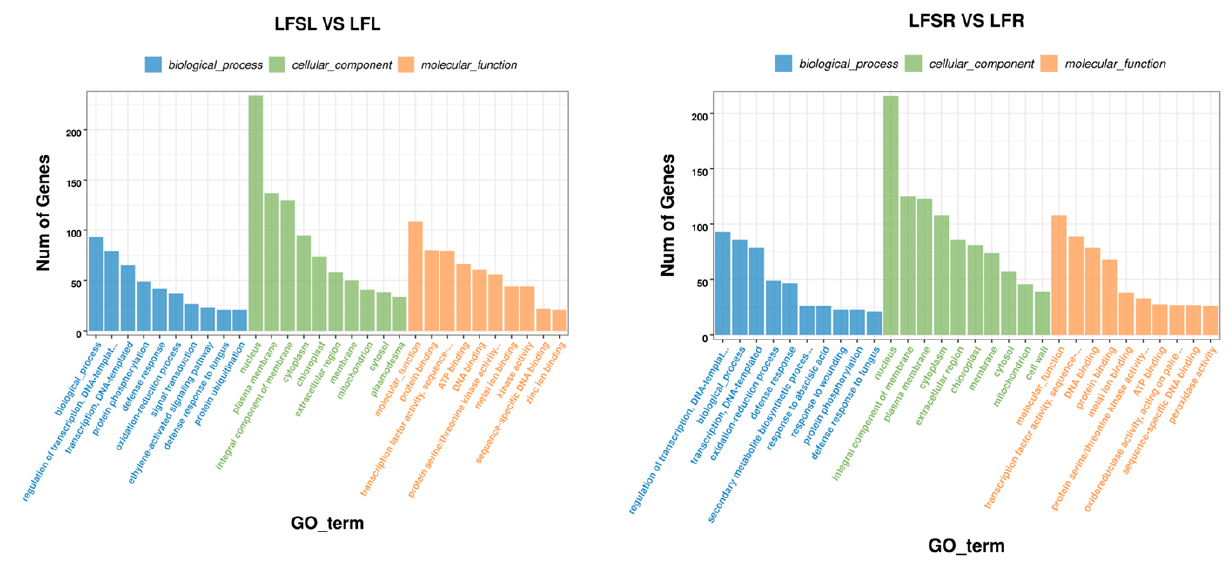
Figure 4. GO enrichment analysis of differently expressed genes. The abscissa represents different GO terms, blue represents biological processes, green represents cellular components, orange represents molecular functions and ordinate represents the number of differentially expressed genes. LFSL vs. LFL, Low Fe + Spd_Leaf sample vs. Low Fe_Leaf sample; LFSR vs. LFR, Low Fe + Spd_Root sample vs. Low Fe_Root